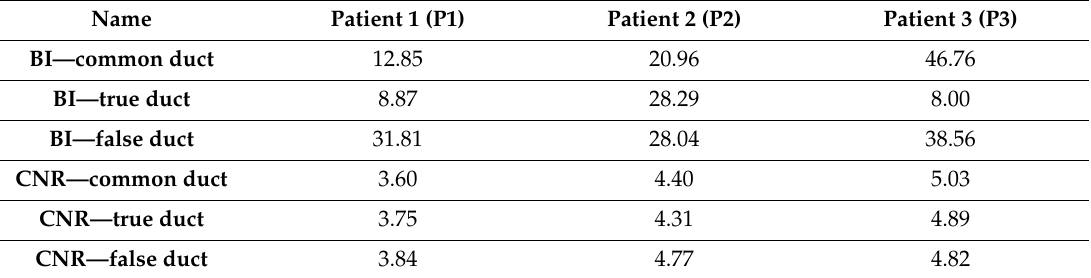
Table 2. Brightness intensity (BI) and contrast to noise ratio (CNR) for the analyzed